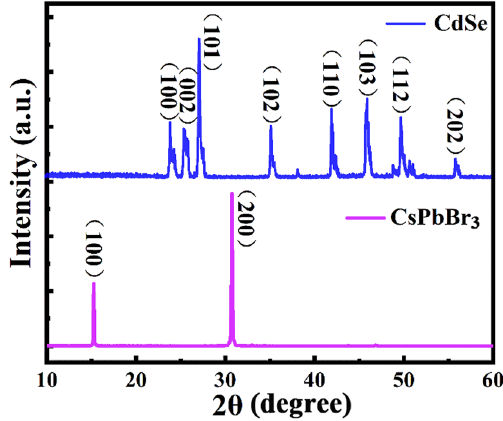
Figure 3: XRD of CdSe NBs (blue) and CsPbBr